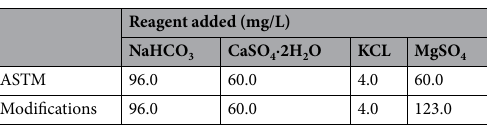
Table 1. Concentration modifications from